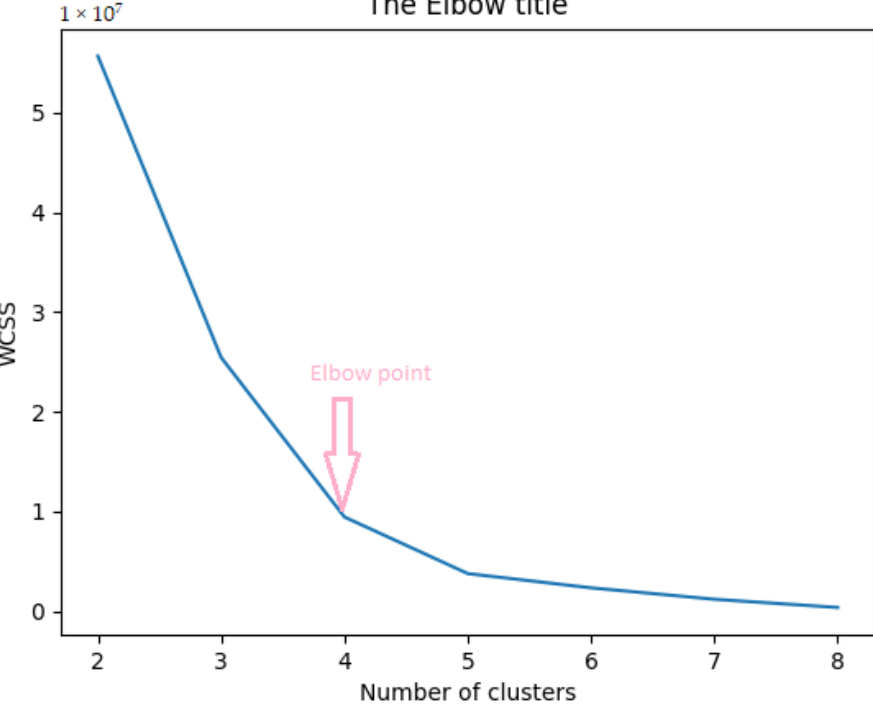
Figure 3. Elbow method to find the value of K (number of clusters) for K-means clustering of all fourteen species. WCSS denotes Within-Clusters Sum of